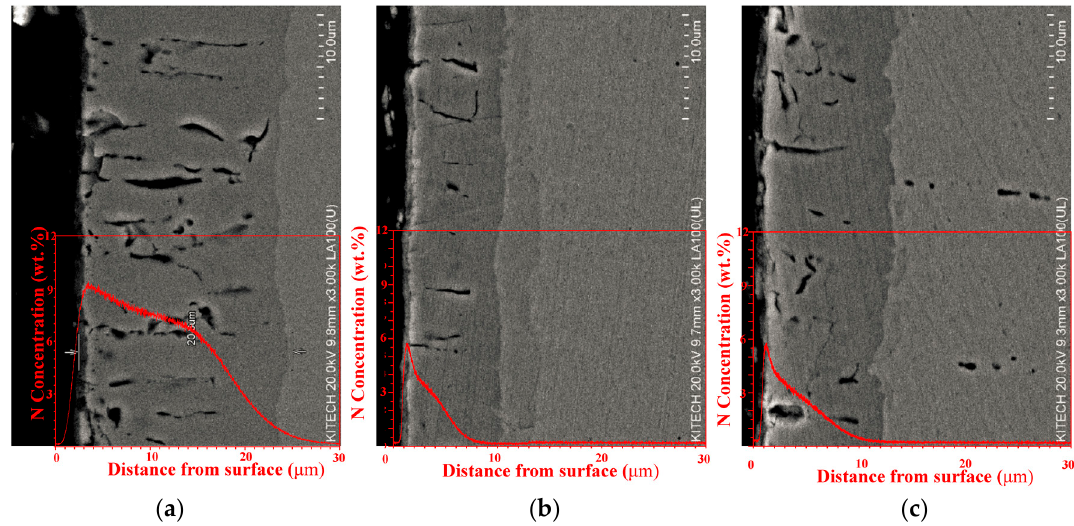
Figure 4. Cross-sectional SEM micrograph obtained perpendicular to the nitrogen diffusion direction from the gas-nitrided pure iron with various nitriding potential and the change in the nitrogen weight percent from GDS analysis: Gas-nitrided pure iron with ( a ) 1.4, ( b ) 0.38 and ( c ) 1st stage: 1.4 and 2nd stage: 0.38 of nitriding potential at 570 °C for ( a ), ( b ) 4 h and ( c ) 1st stage: 4 h and 2nd stage: 2 h.